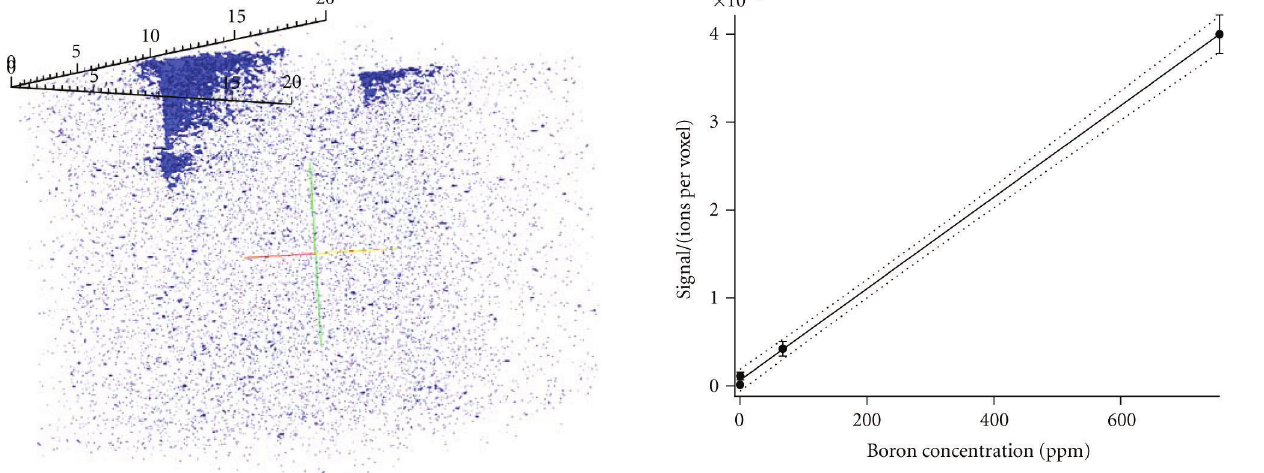
Figure 5: Three-dimensional display of sodium secondary ions from the nickel finder grid shown in Figure 4. It can be seen that the sodium is concentrated in two locations, both at the surface of the sample. The tailing in the z direction may be due to the shape of the sodium deposit on the nickel grid or may also be in part due to ion-beam-induced roughening and mixing. The x and y dimensions are 20 µ m as for Figure 4; the z dimension is unknown, but is orders of magnitude less than this. The view is of isointensity surfaces after thresholding to remove background counts.